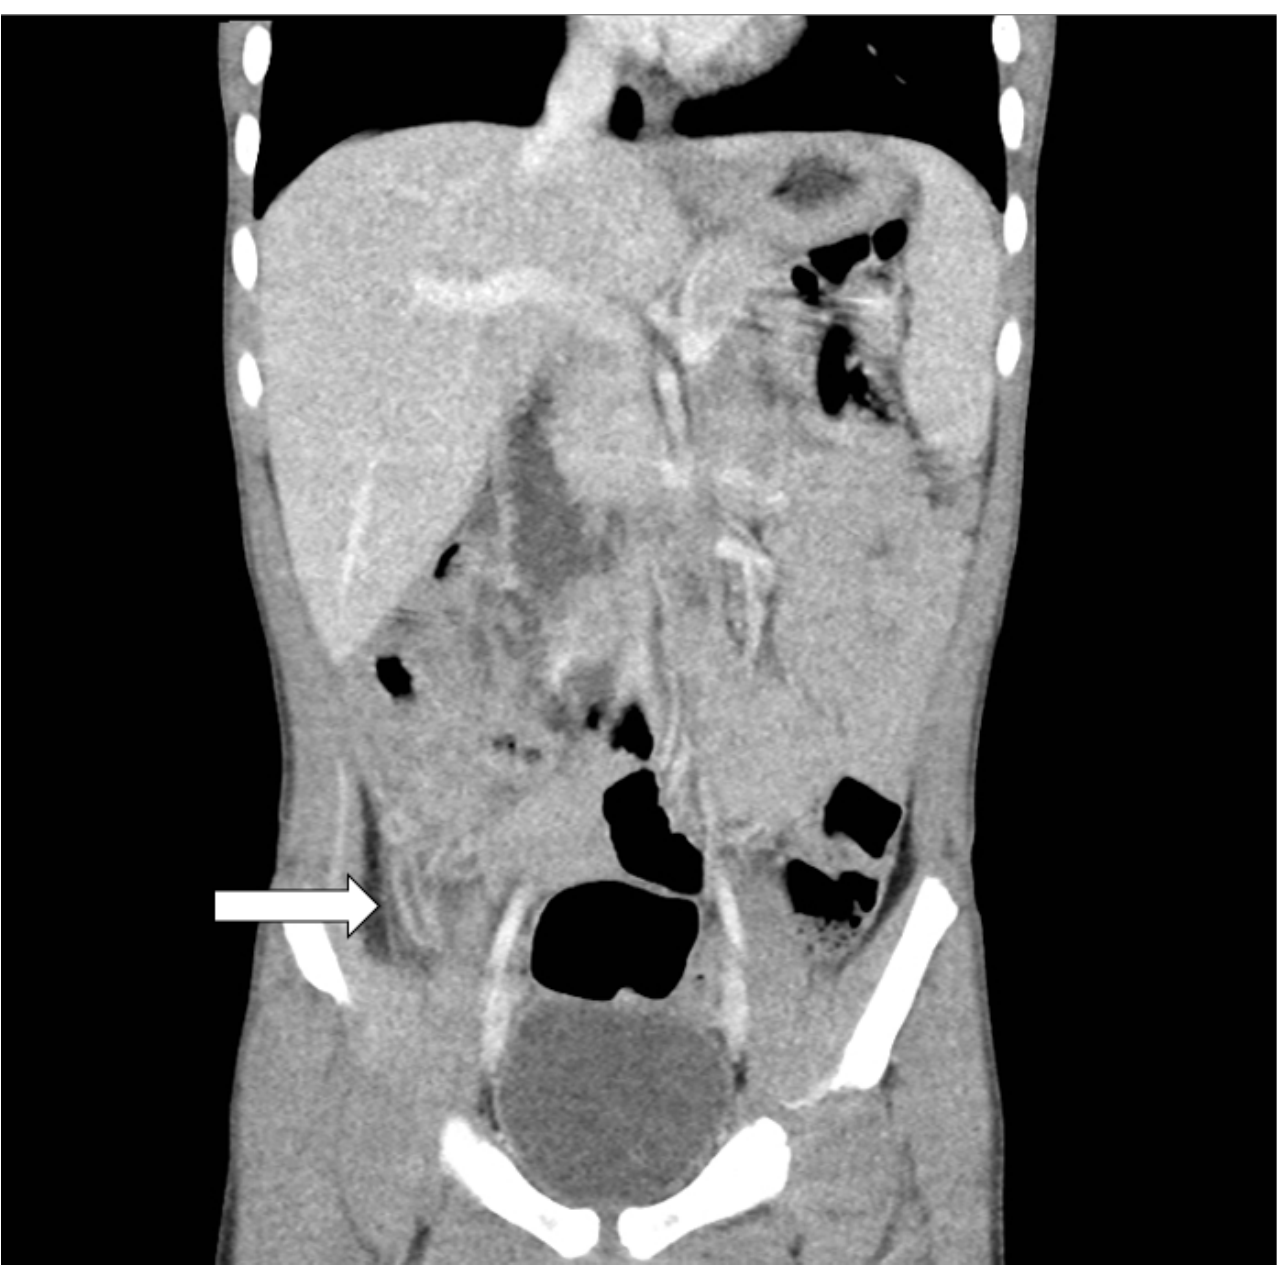
Figure 1. Computed tomography of abdomen demonstrated appendicitis (arrow).